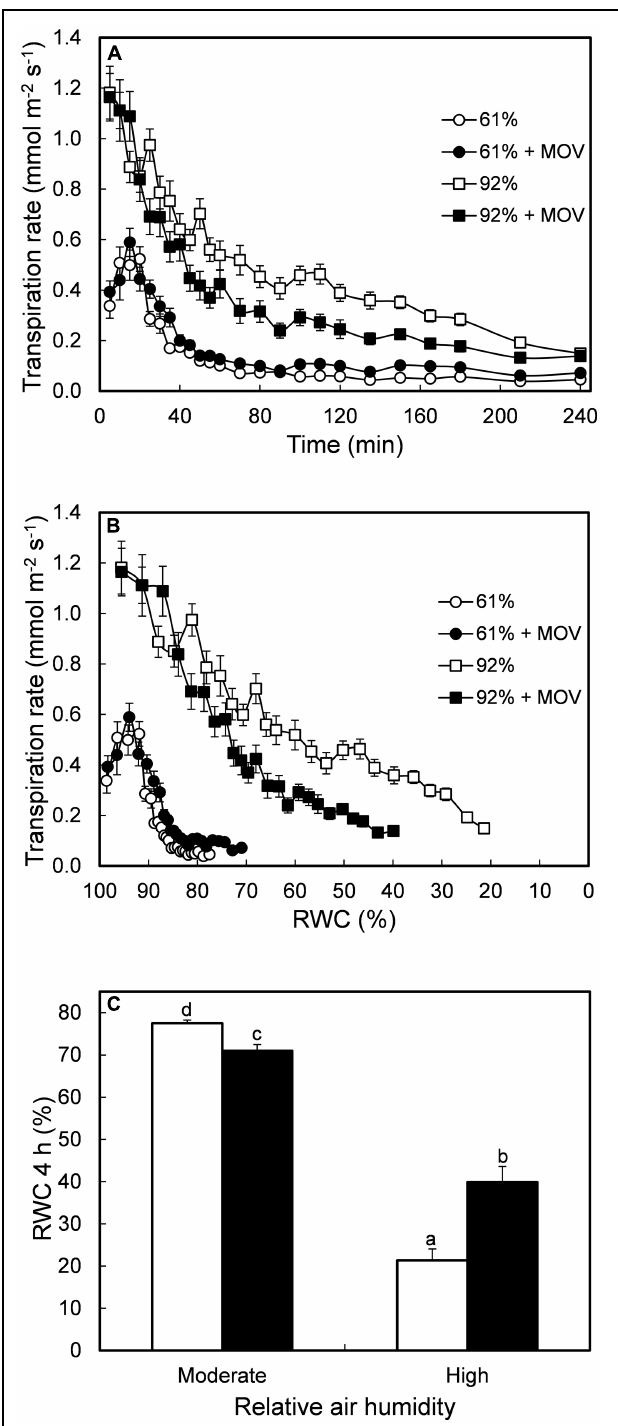
FIGURE 2 | Transpiration rate as a function of time of desiccation (A) and as a function of RWC (B) during 4 h of leaflet desiccation. RWC after 4 h of leaflet desiccation (C) . All measurements were conducted in pot rose cv. ‘Toril’ grown at moderate (61%; circles) or high (92%; squares) RH, without (open symbols) or with (solid symbols) additional MOV. Values are the mean of 28 detached leaflets and bars represent SEM. Different letters indicate significant differences according to Fisher’s LSD test ( P =